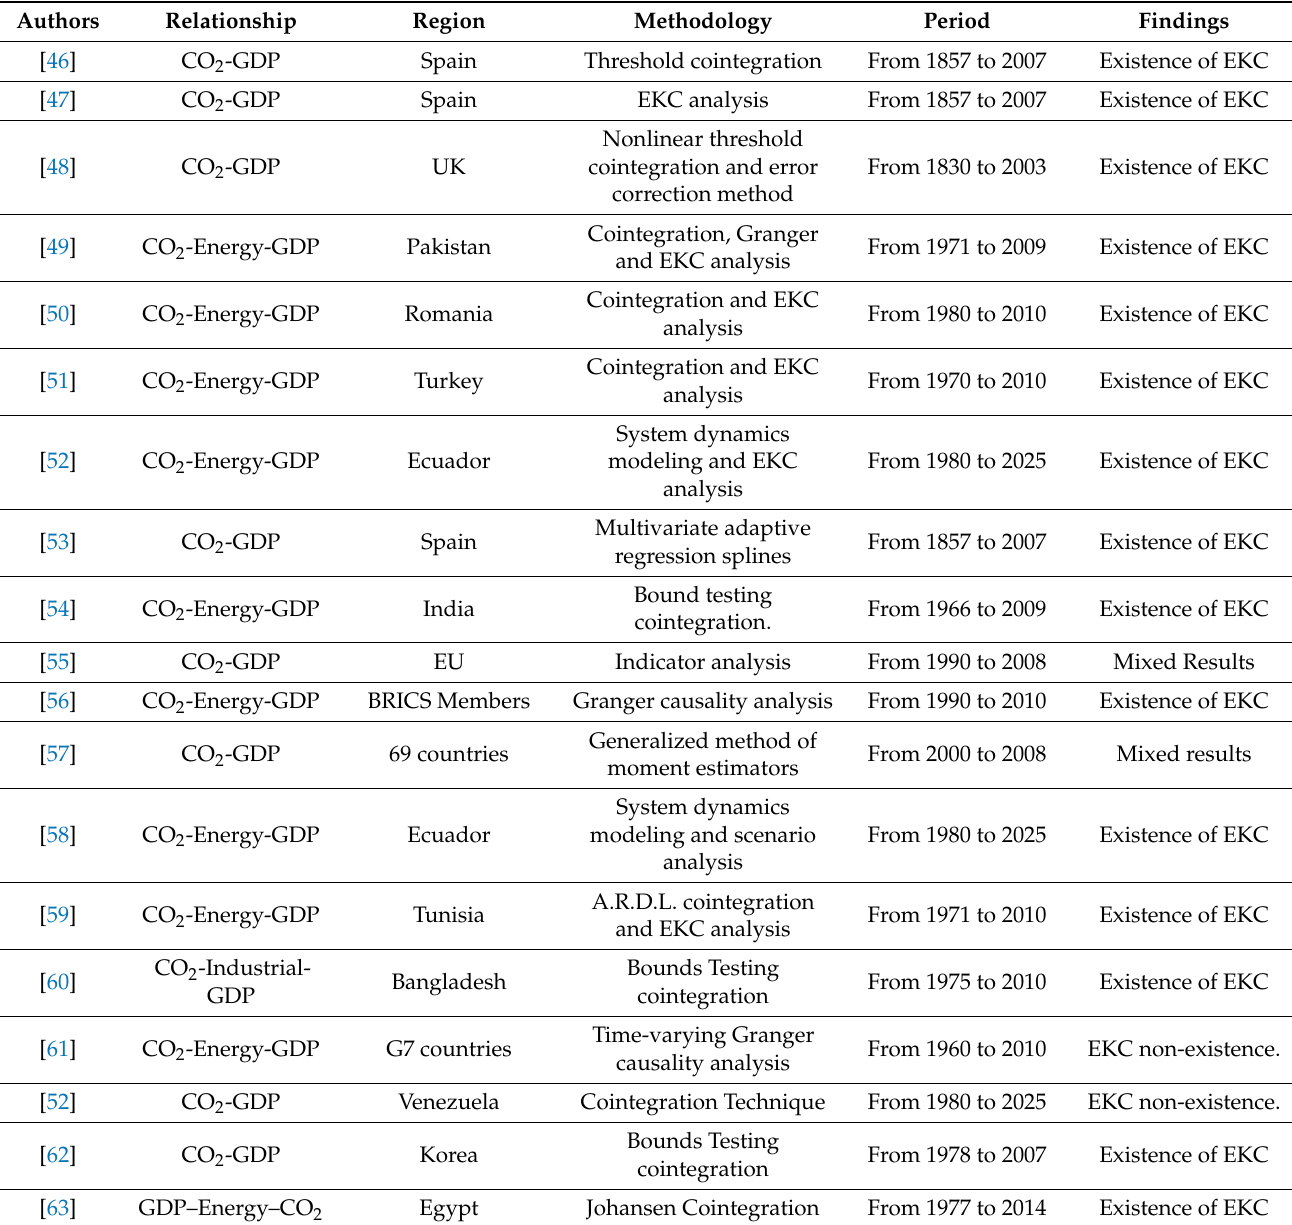
Table 1. Summary of related studies and